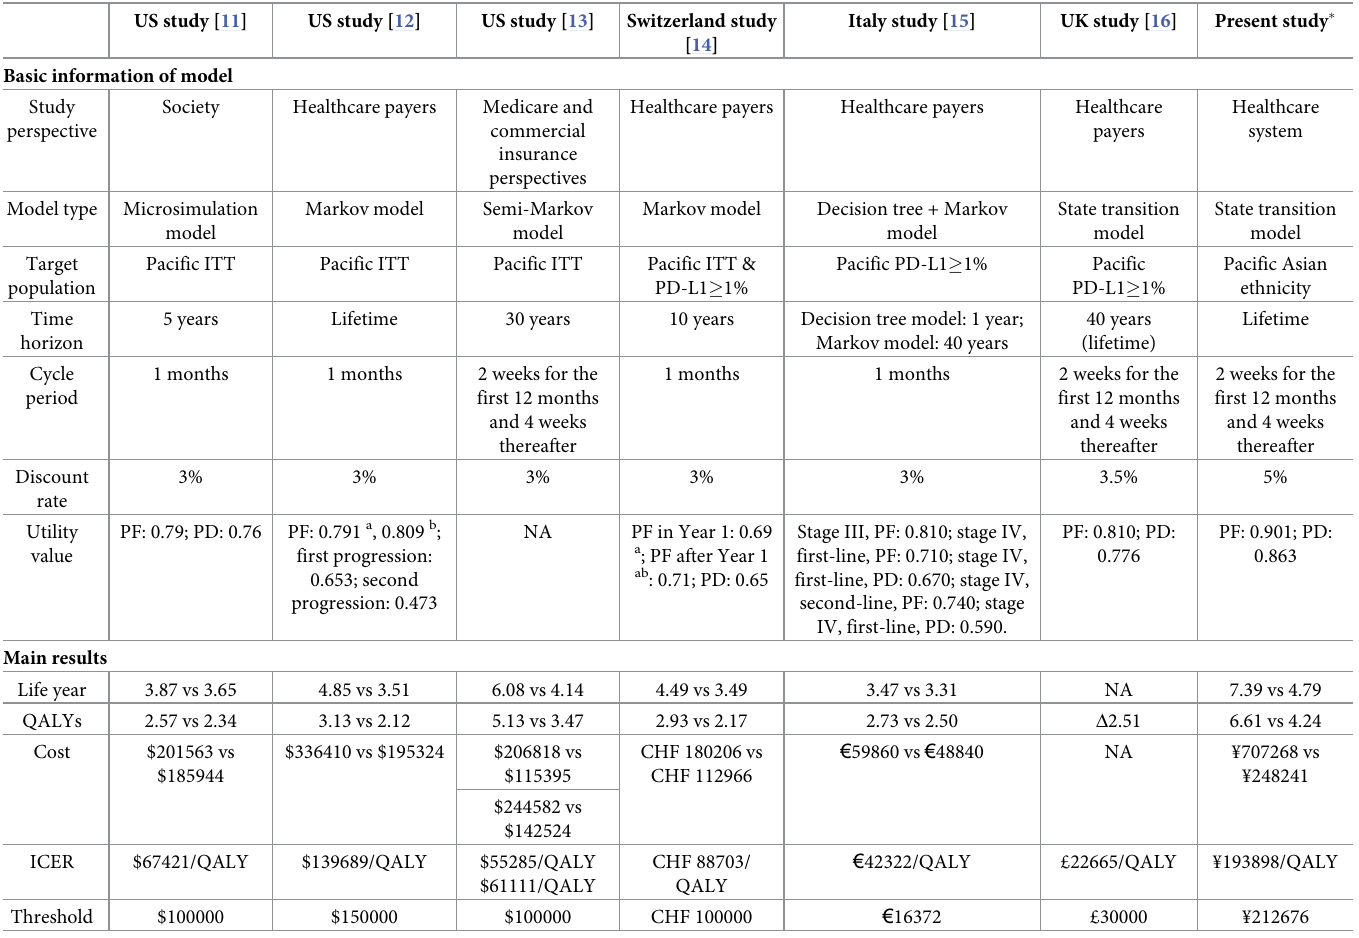
Table 4. Comparison of cost-effectiveness studies on durvalumab.